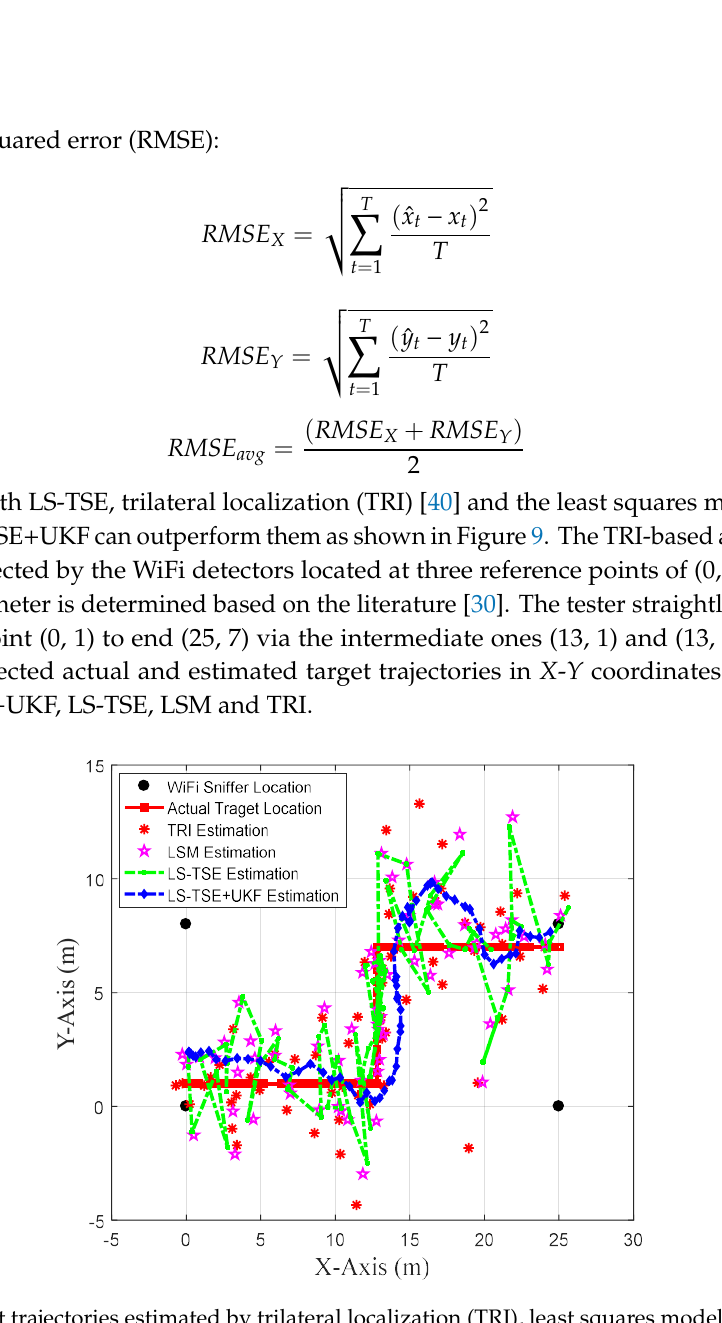
Figure 9. Target trajectories estimated by trilateral localization (TRI), least squares model (LSM), least squares Taylor series expansion (LS-TSE) and LS-TSE+unscented Kalman filter (UKF).